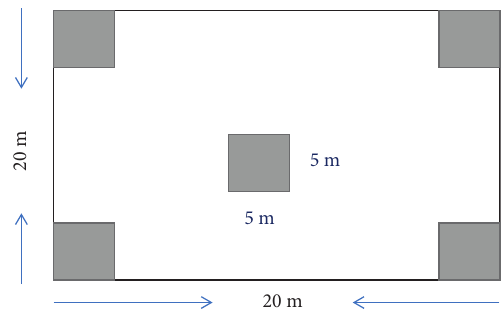
Figure 2: Sampling design